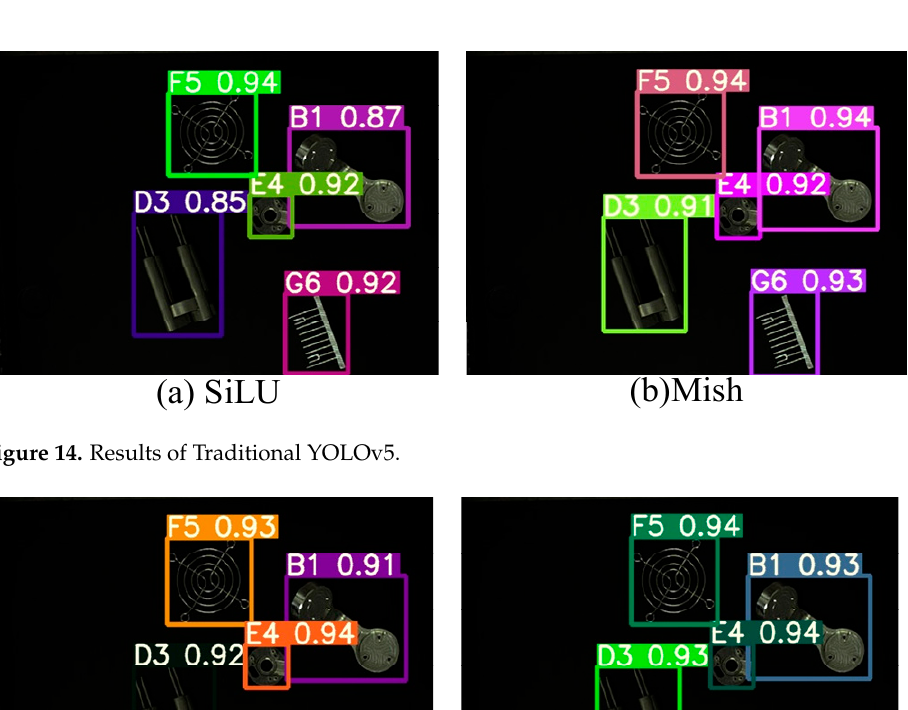
Figure 13. Example of an input image.